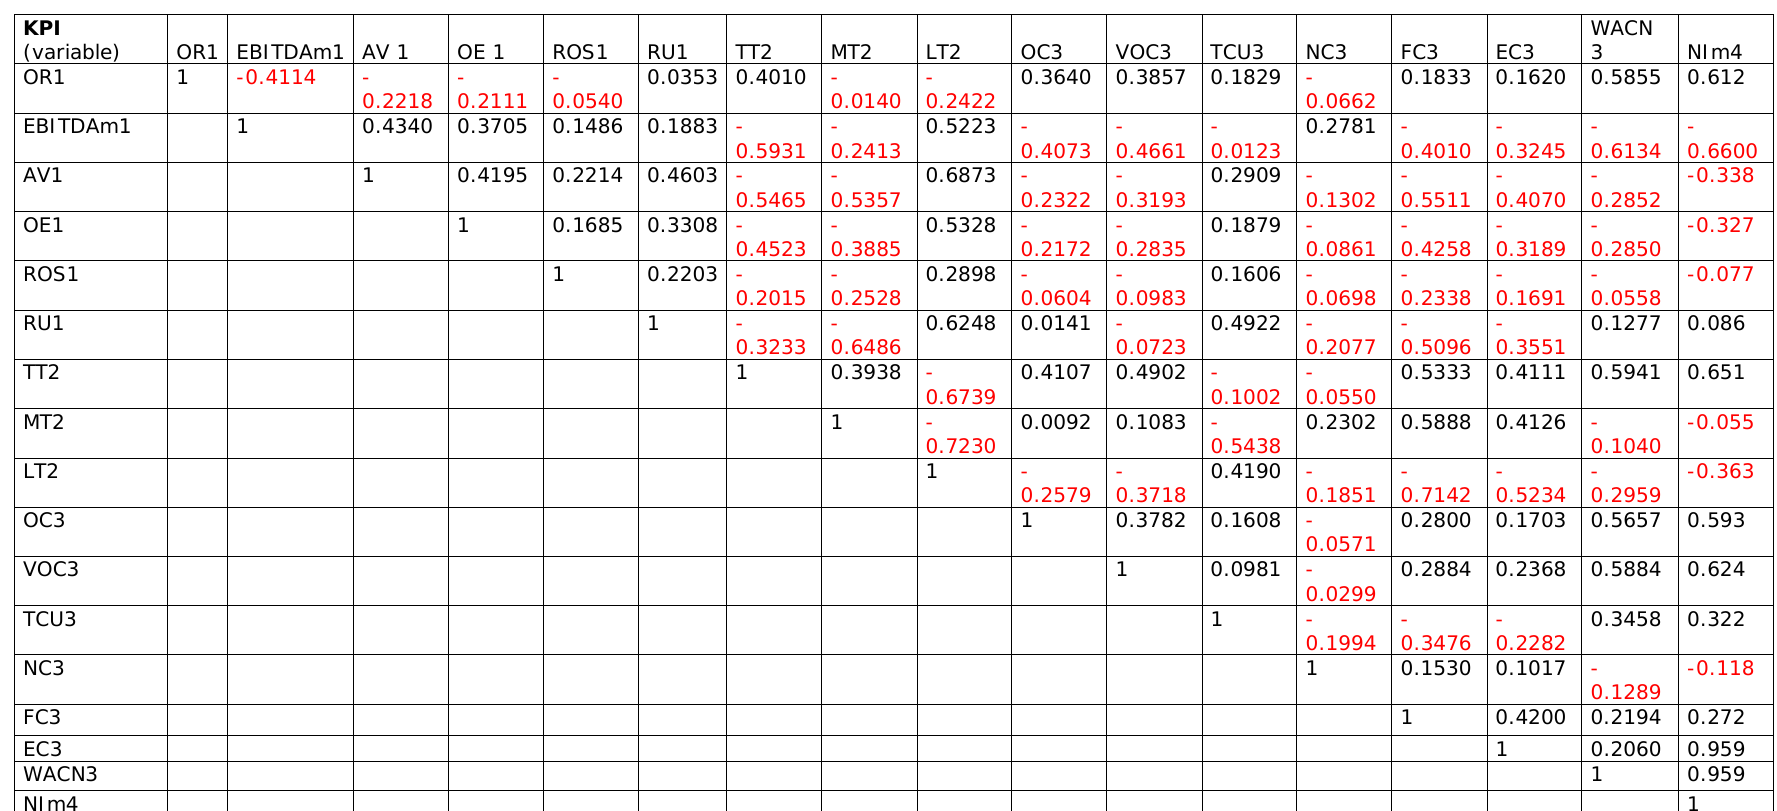
Table 5. “Correlation Matrix 2006 (Ordinal), Note: Abbreviations for variables are explained in Table